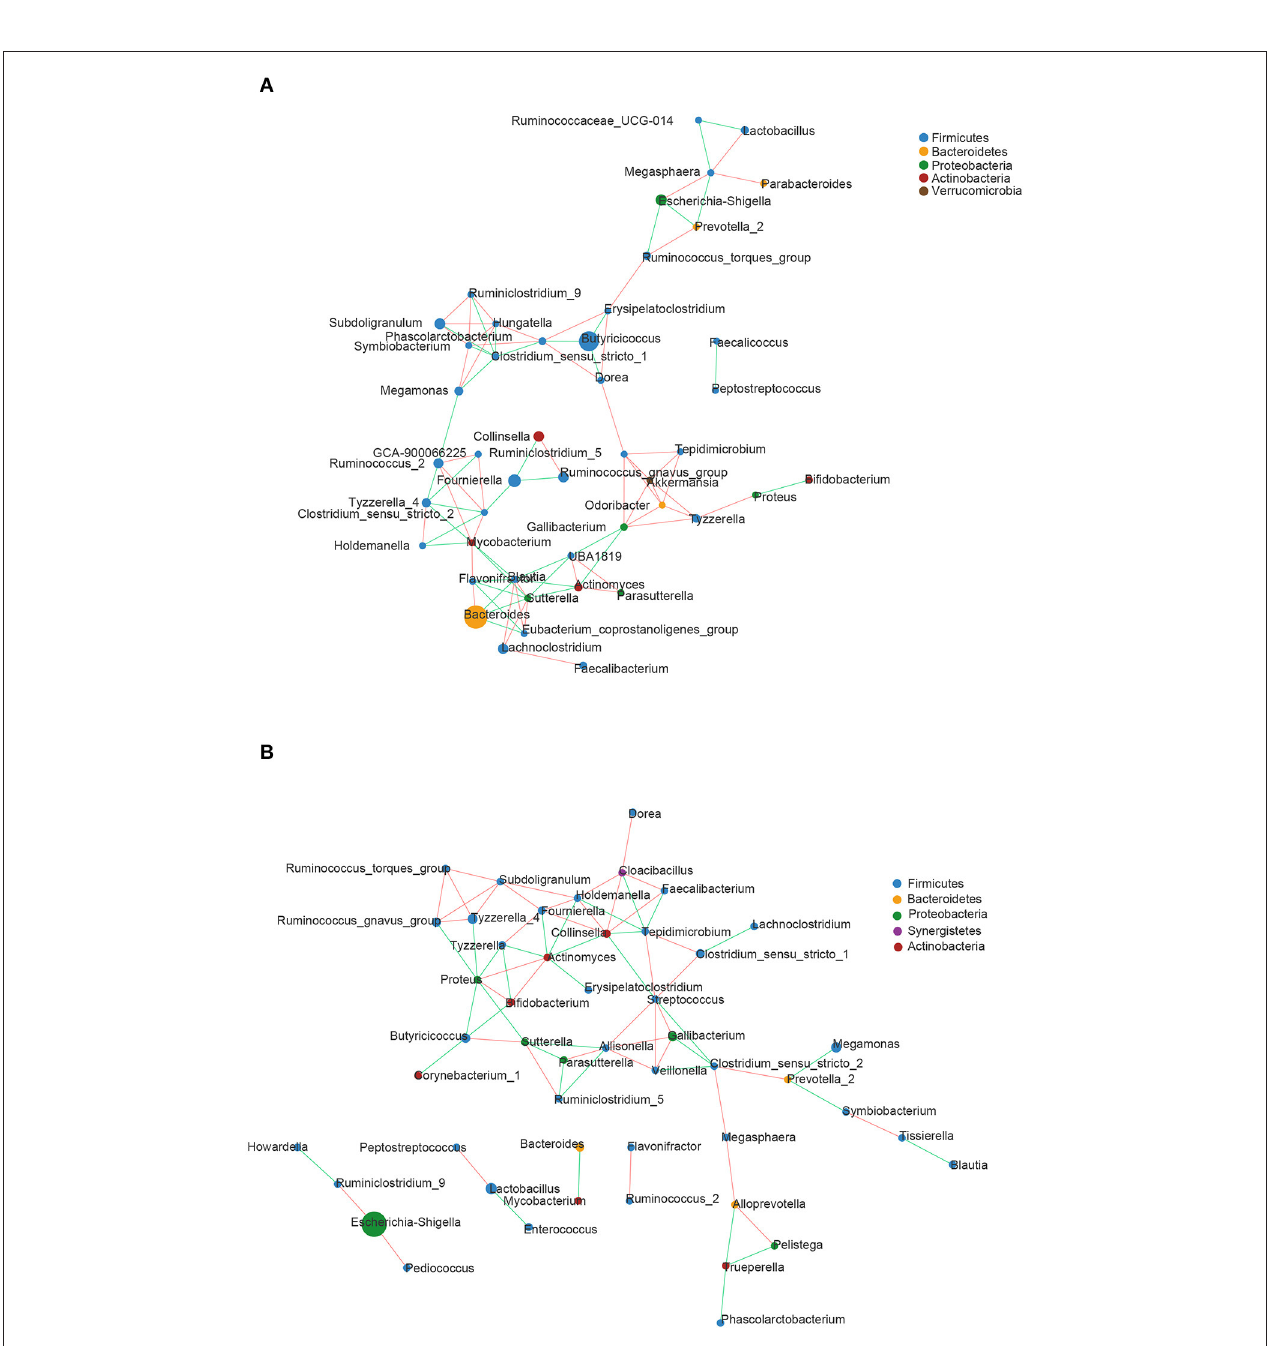
FIGURE 3 | Correlation network diagrams of the 50 richest abundant genera of (A) healthy and (B) DHD calves. The lines between nodes represent the Spearman correlation and the color intensity represents the correlation coefficient (red, positive; green, negative). The color of the genera was based on phylum affiliation, and the size indicates average relative